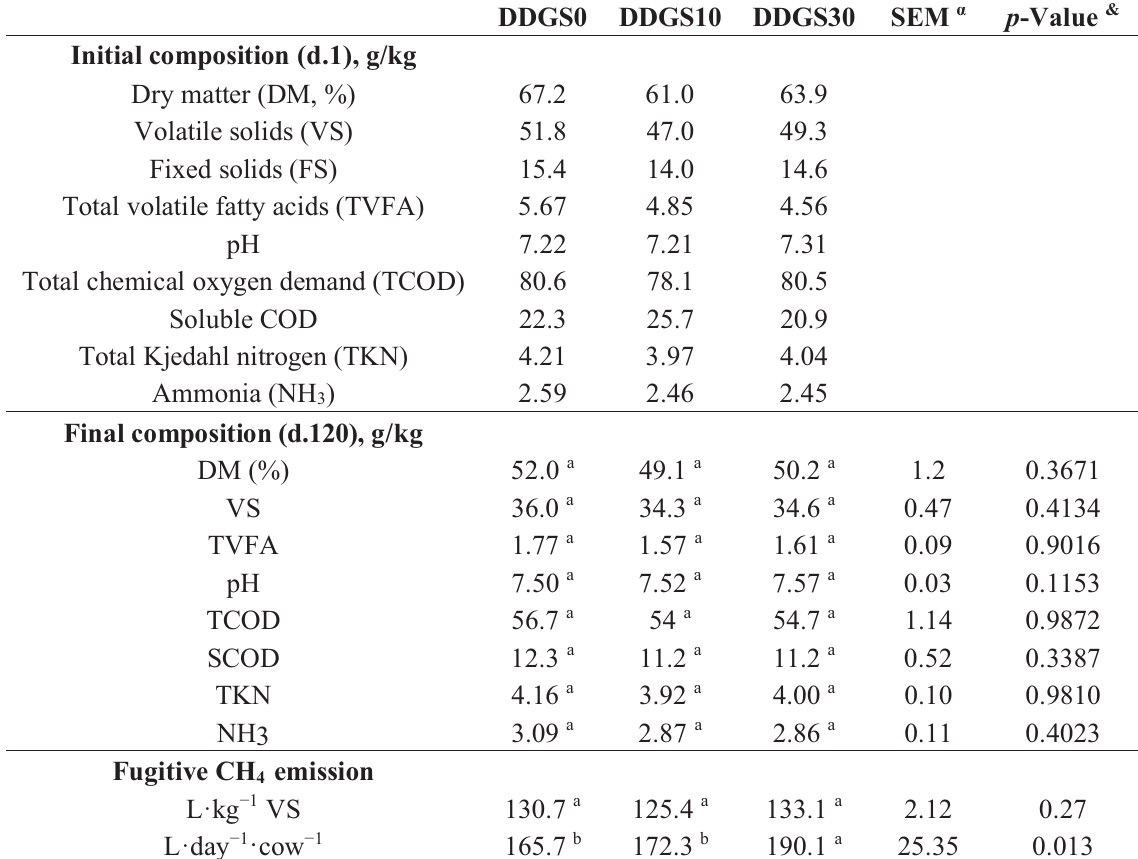
Table 3. Initial and final composition of slurry and fugitive CH 4 emissions during the four-month storage experiment as a function of feeding strategies (inclusion of 0,